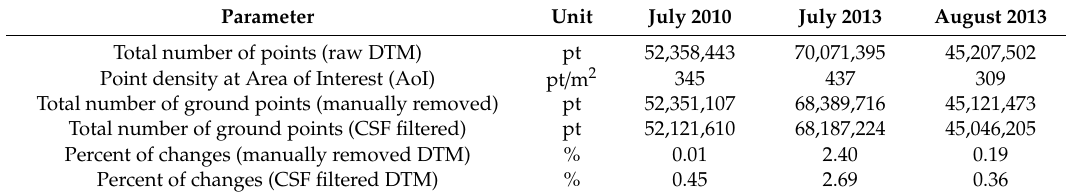
Table 1. Digital Terrain Model (DTM) model parameters from the three measurement campaigns.